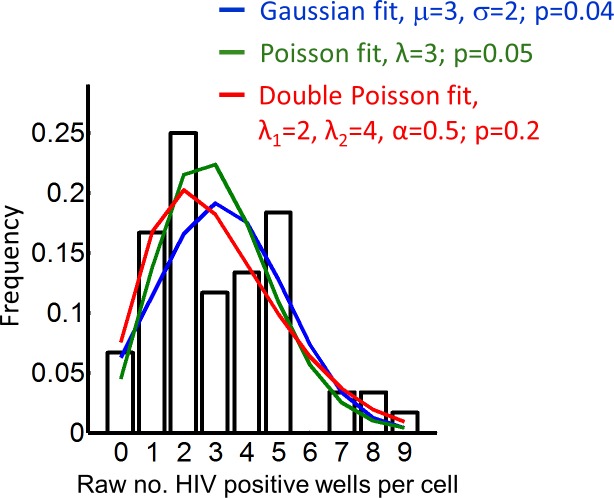
Fitting of different distributions to the frequency of HIV DNA copies per cell.The experimentally determined distribution of the raw number of HIV-positive wells per cell was fitted by a Gaussian distribution (blue line), a Poisson distribution (green line), or a two-peaked Poisson distribution (red line) described by p(m; α,λ1,λ2)=(1-α)λ1me-λ1/m!+αλ2me-λ2/m!, where λ1 and λ2 are the means of the first and second peak, respectively, and α is the fraction of transmissions which fall within the second peak. Only the double Poisson distribution could not be rejected using a chi-square goodness-of-fit test (p=0.2).